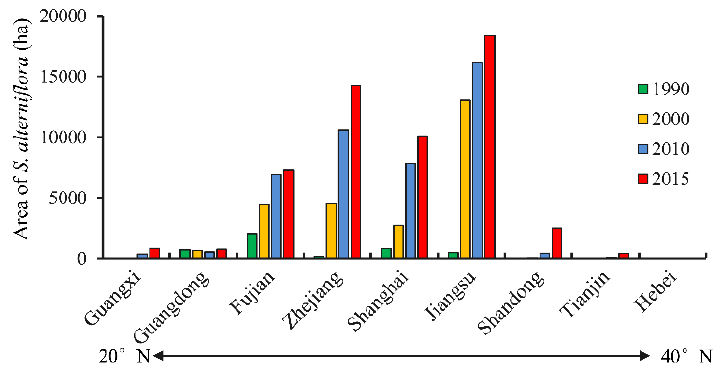
Figure 3. Spatial variation of S. alterniflora invasion.